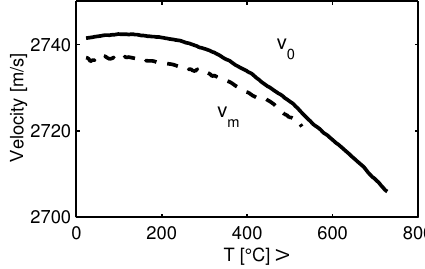
Figure 10. Phase velocity of Rayleigh waves on free surface v 0 (solid line) and on metallized surface v m (dotted line), cut (0, 138.5, 26.6 ◦ ).